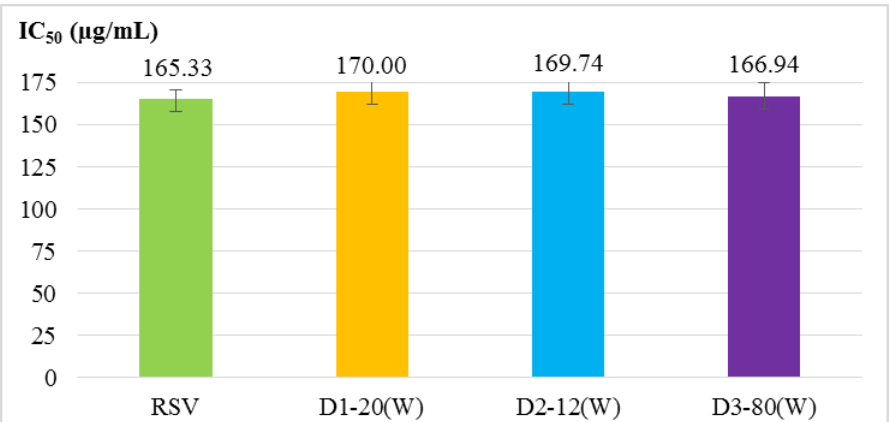
Figure 1. DPPH radical scavenging activity of RSV and RSV transfersomes (D1–20(W), D2–12(W), and D3–80(W) groups). The IC 50 value is the sample to remove the 50% DPPH radicals (2.4 × 10 −4 M) required concentration. The values are means ± SD.